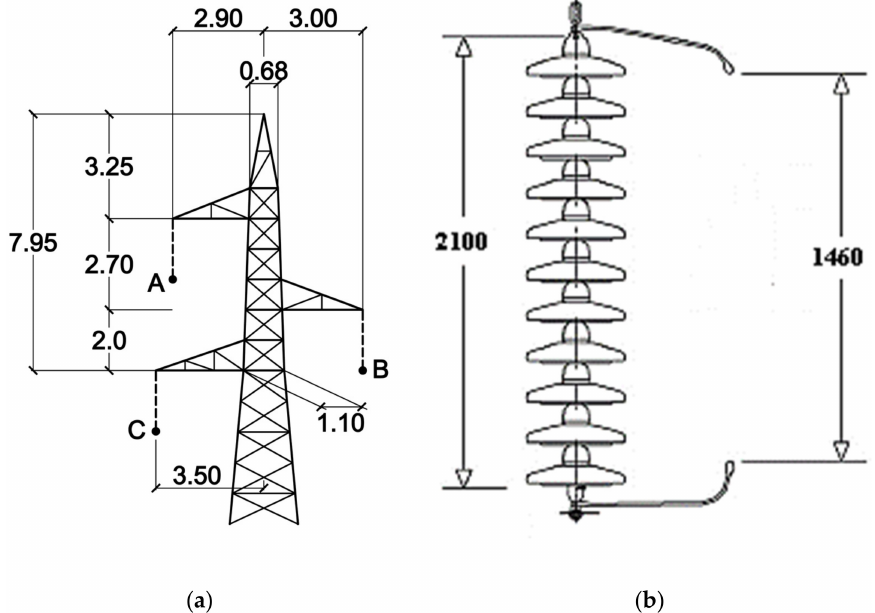
Figure 1. ( a ) 150 kV overhead transmission line (OHL) tower outline (dimensions are expressed in meters). ( b ) Line insulation (dimensions are expressed in